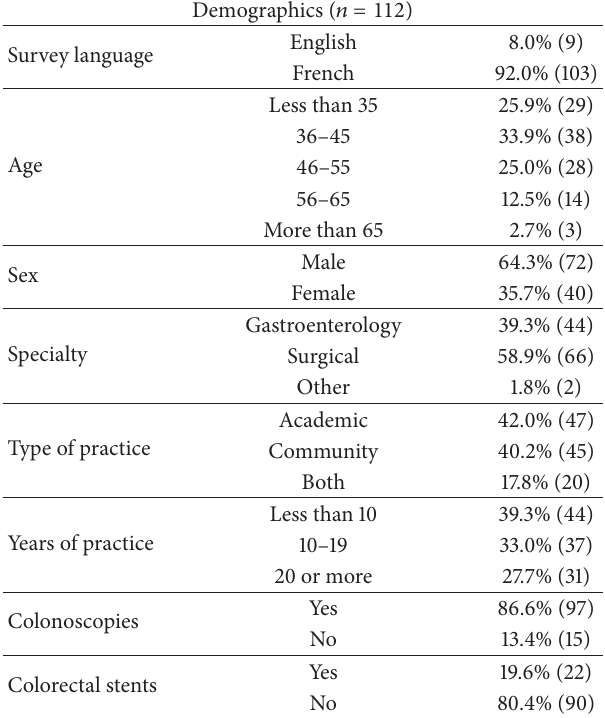
Table 1: Baseline characteristics of survey